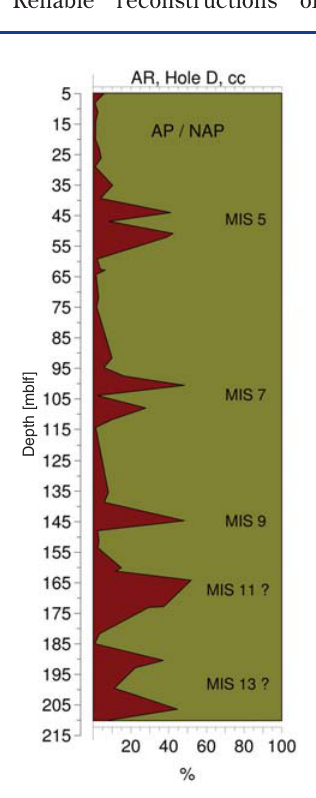
Figure 17. Pollen ratio between trees (arboreal pollen in red: AP) versus herbs (non-arboreal pollen in green: NAP) from Lake Van (AR, hole D, core catcher samples) and tentative correlation with marine isotope stages (MI S